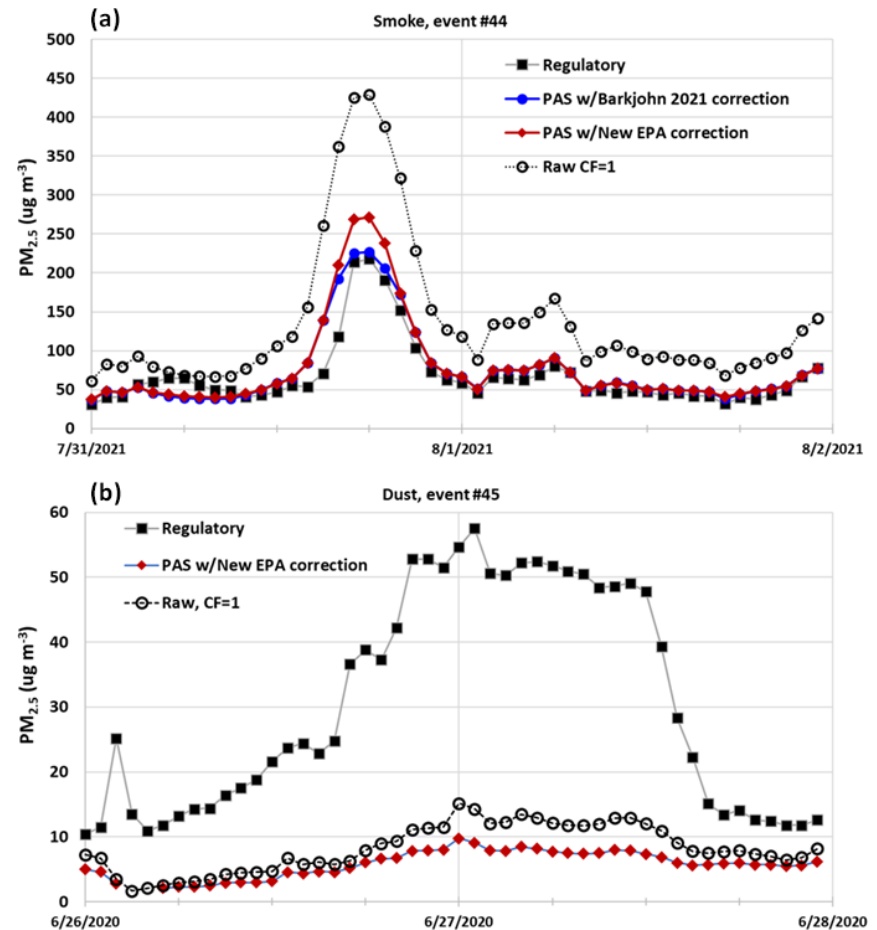
Figure 1. Time series of hourly regulatory and PAS PM 2 . 5 (raw and corrected) data for two events, no. 44 (smoke, a ) and no. 45 (dust, b ). Time is in UTC. Note that for the dust event (no. 45), the two correction schemes give identical results. Details on the sites used for these figures are given in Tables S1 and S3. For event no. 44, the slopes (using Eq. 2) comparing the Barkjohn 2021 and new EPA correction schemes are 0.81 and 0.70, respectively. For event no. 45, the slope using the Barkjohn 2021 correction scheme is 6.76. Please note that the date format used in this figure is month/day/year.